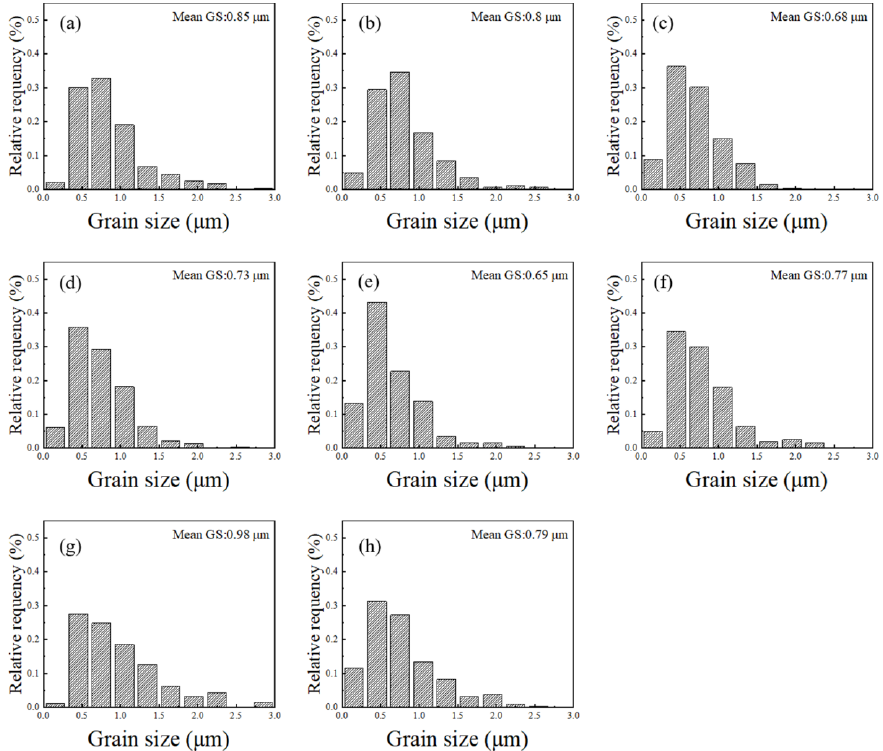
Figure 6. The grain size distribution in WC-13Co with different additions of Mo and C, ( a ) 0Mo-5.13C, ( b ) 1Mo-5.07C, ( c ) 2Mo-5.01C, ( d ) 2.5Mo-5.0C, ( e ) 2.5Mo-5.3C, ( f ) 2.5Mo-5.45C, ( g ) 2.5Mo-5.75C, ( h ) 2.5Mo-6.1C.